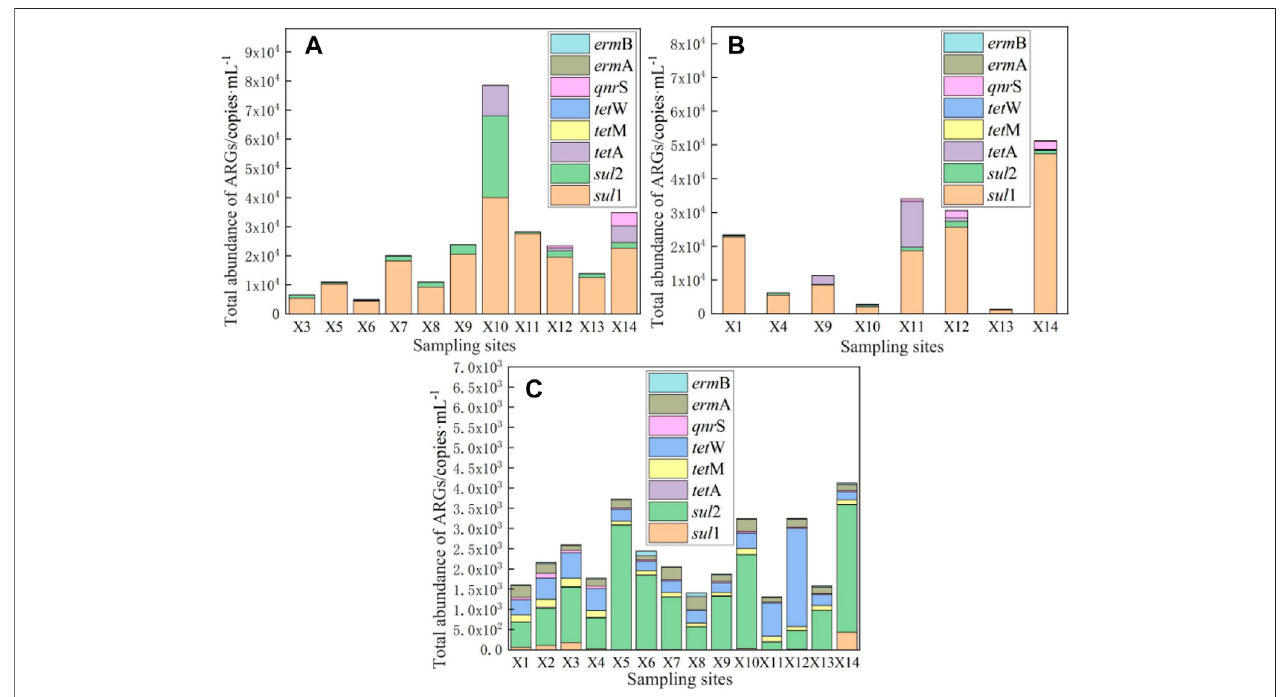
FIGURE 6 | Total abundance of ARGs in the surface water of East Dongting Lake in spring (A) , summer (B) , and fall (C) .